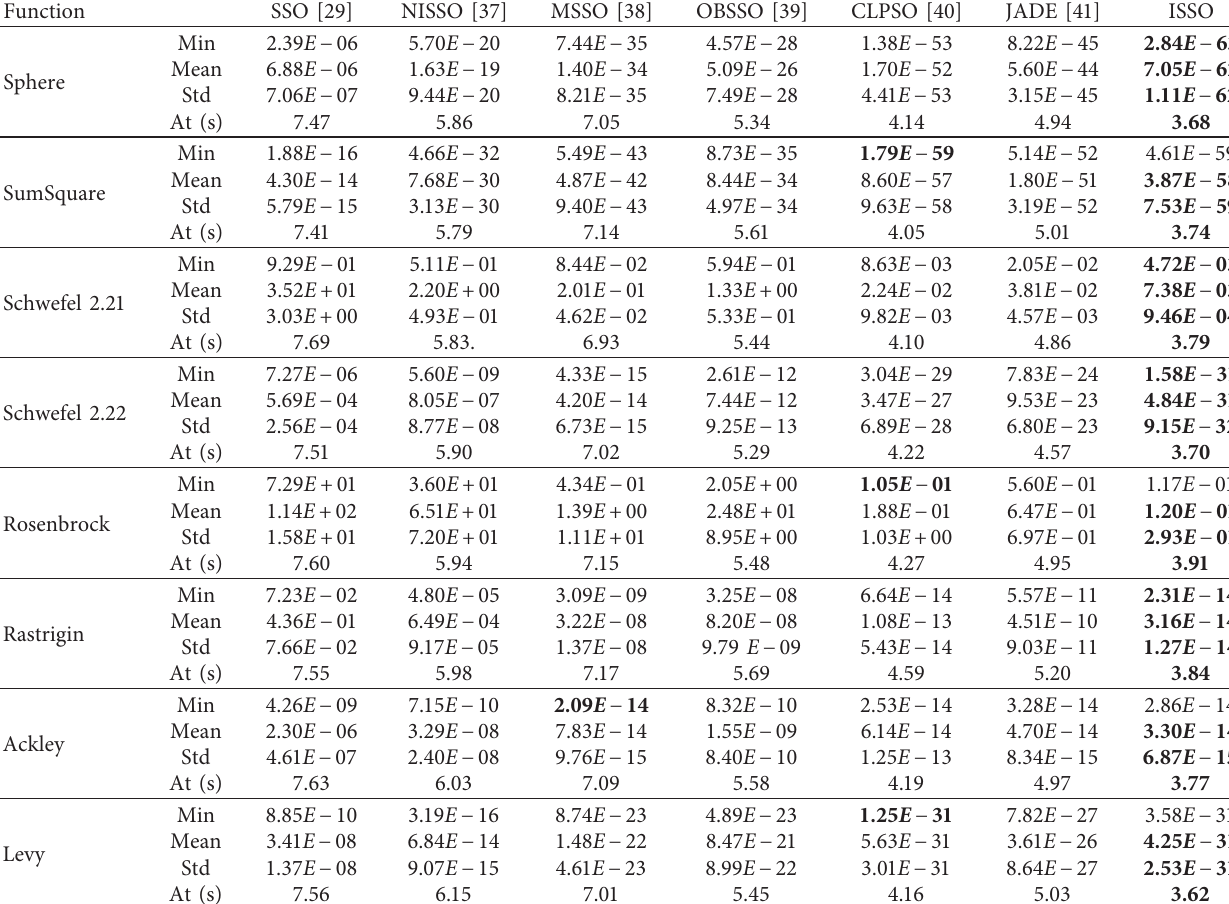
Table 3: Comparisons of the results among the algorithms with D � 50. Function